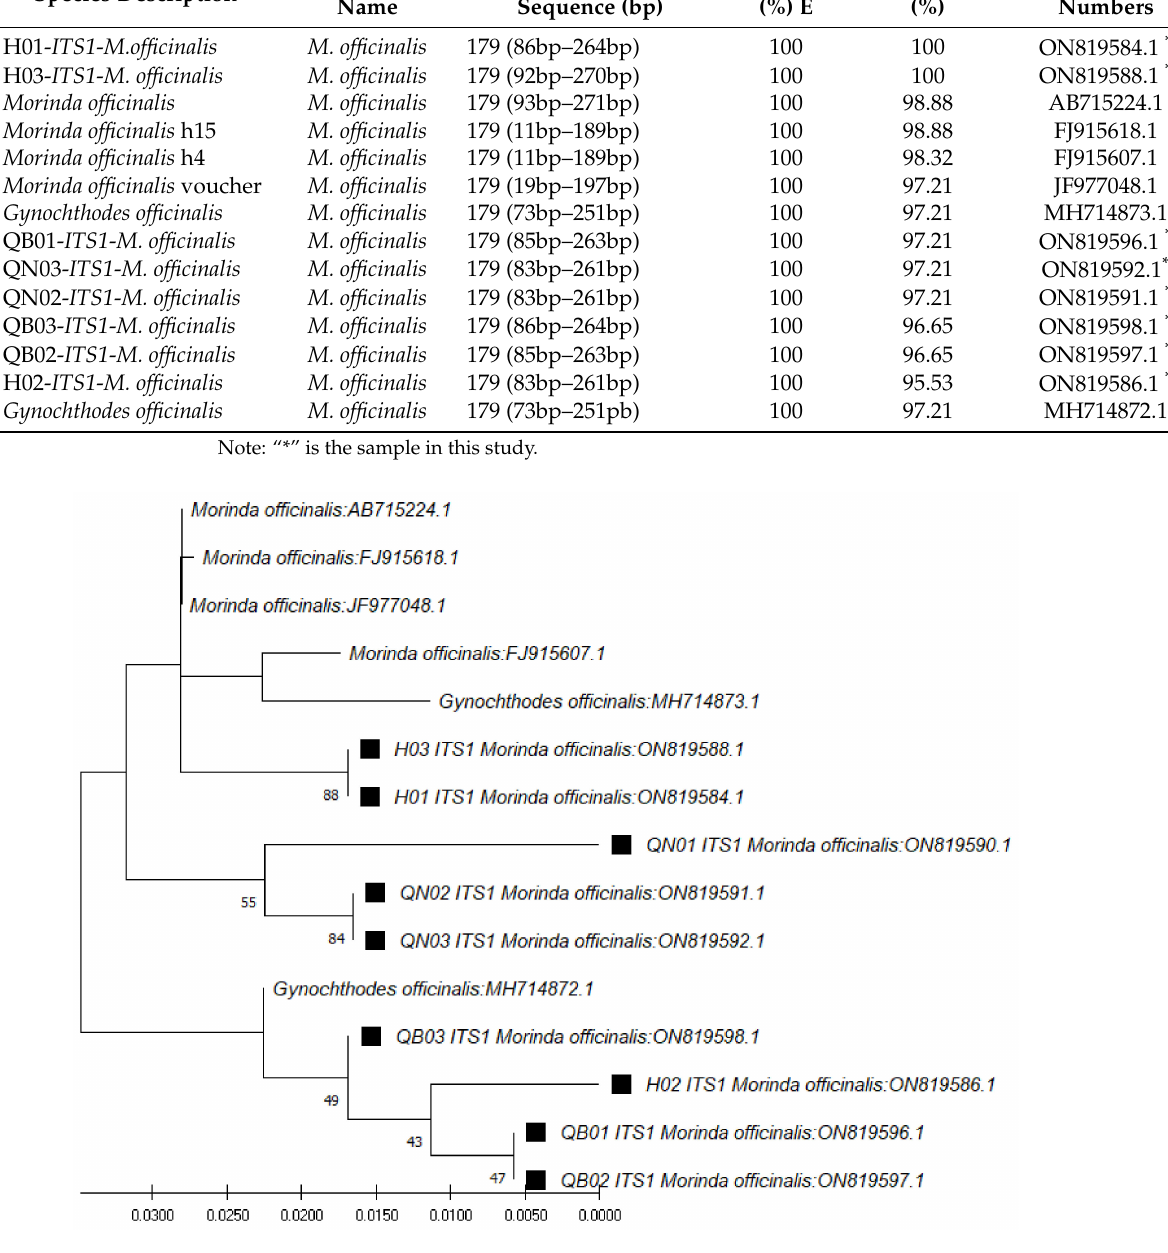
Figure 2. Phylogenetic tree by the maximum likelihood of similarity between M. officinalis and the closest species as per ITS1 region sequences. The samples of our study are marked by black squares next to their